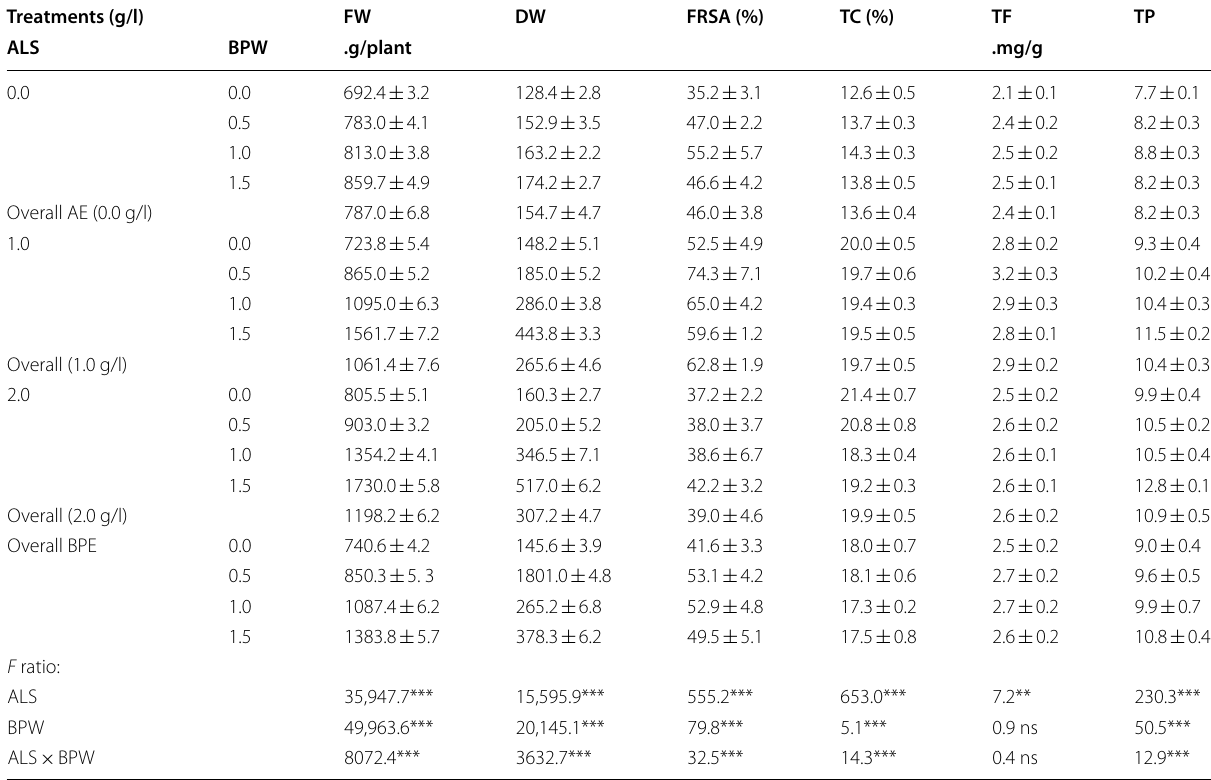
** P < 0.01 (moderate significant), *** P < 0.001 (highly significant)